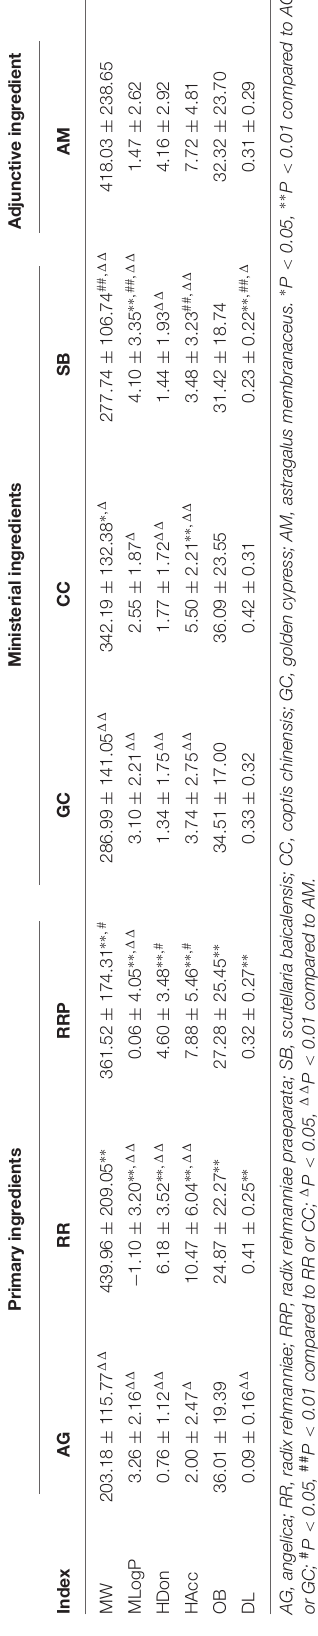
Bioengineering Institute, Nanjing, China) in accordance with the manufacturer’s